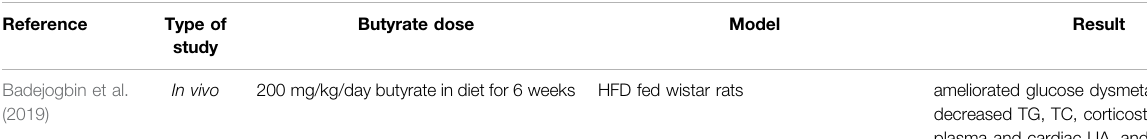
TABLE 2 | Summary of the studies about the effects of Butyrate on heart failure.